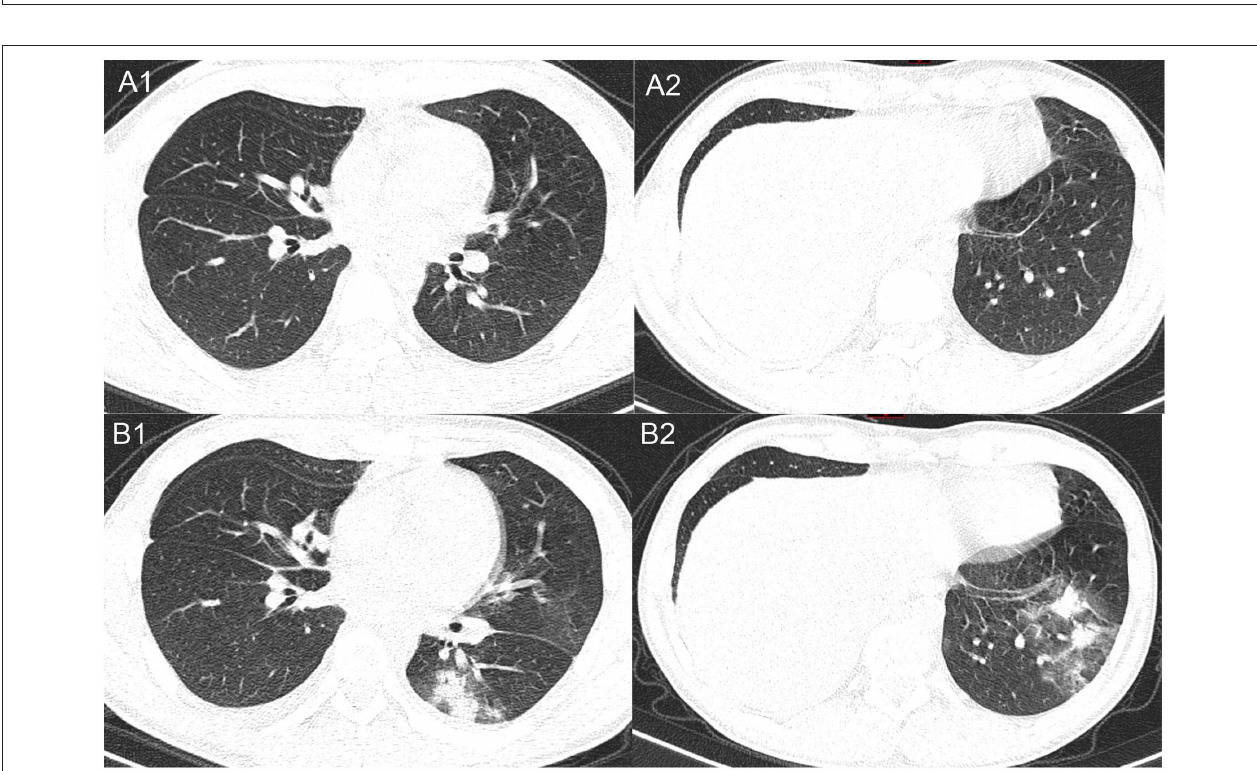
FIGURE 2 | Representative images of the chest CT comparing between January 19, 2020 (A1, A2) , and January 27, 2020 (B1, B2) . The later CT images show multifocal opacities and consolidations in different lobes of the lungs.